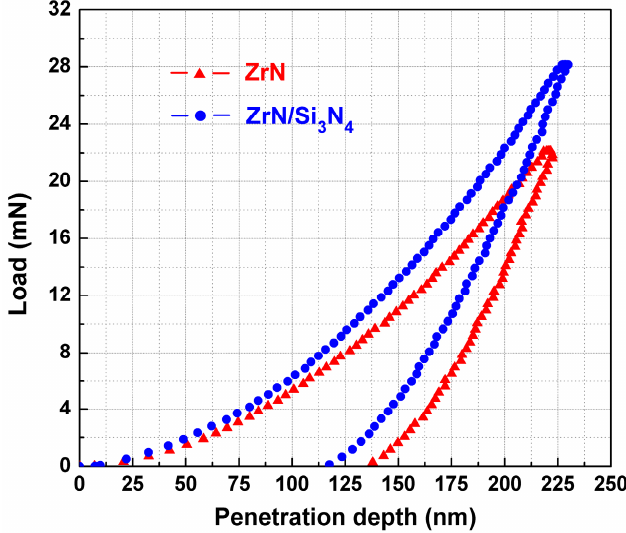
Figure 3. The loading vs. penetration depth curves of the nanoindentation tests applied on the ZrN and ZrN/Si 3 N 4 multilayer coating surface.